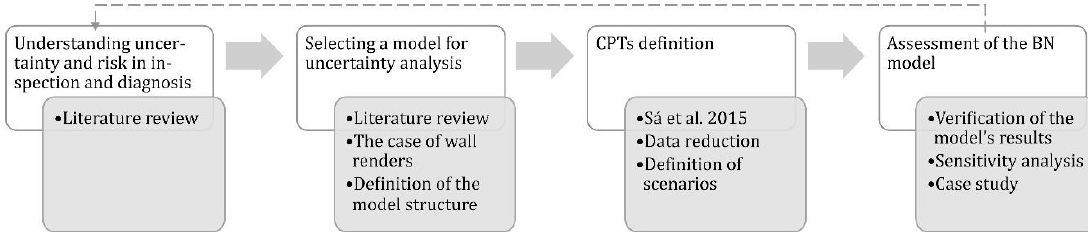
Figure 1. Framework of the methodology.